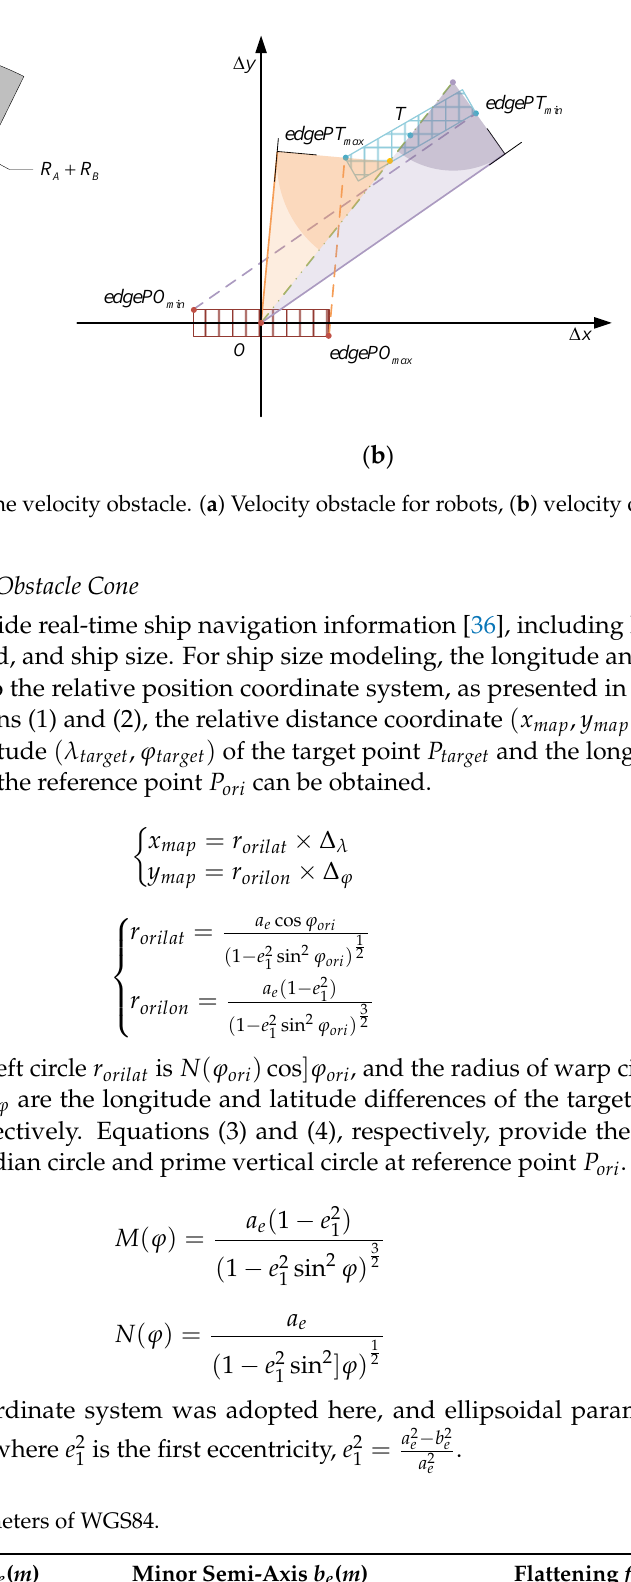
Table 1. Ellipsoid parameters of WGS84.